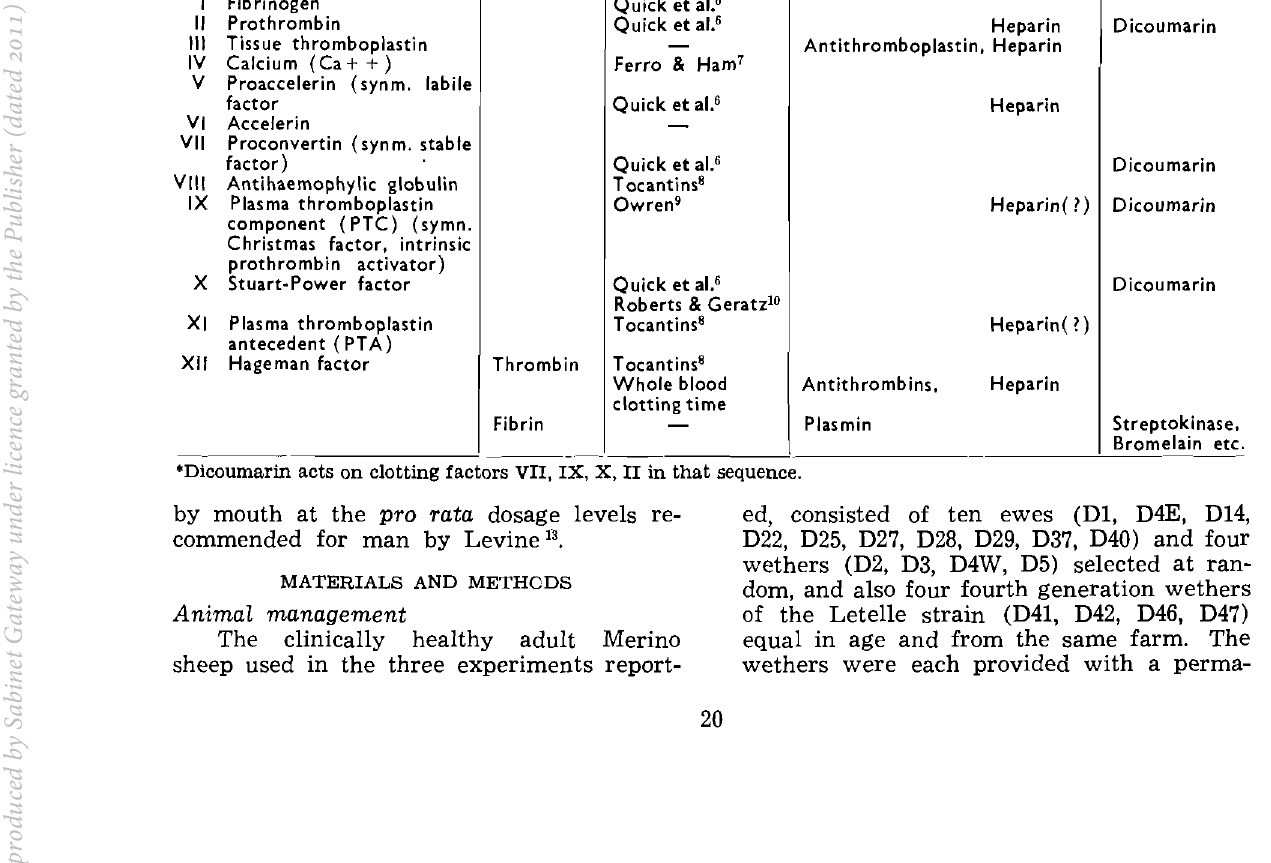
Table I: THE BLOOD CLOTTING FACTORS ACTING ON THROMBIN AND FIBRIN, THEIR ESTIMATION AND